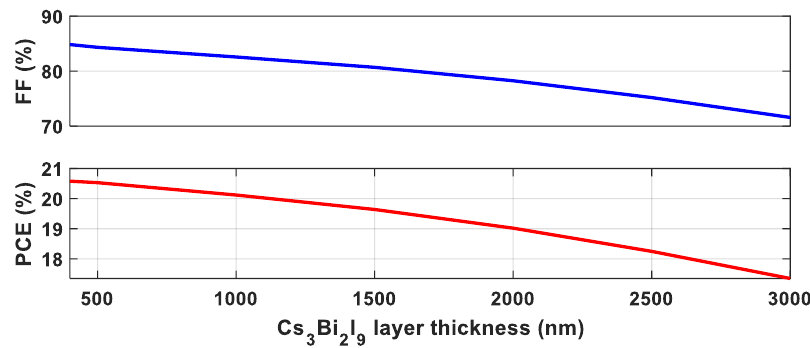
Figure 3. Effect of Cs 3 Bi 2 I 9 thickness on the performance parameters.